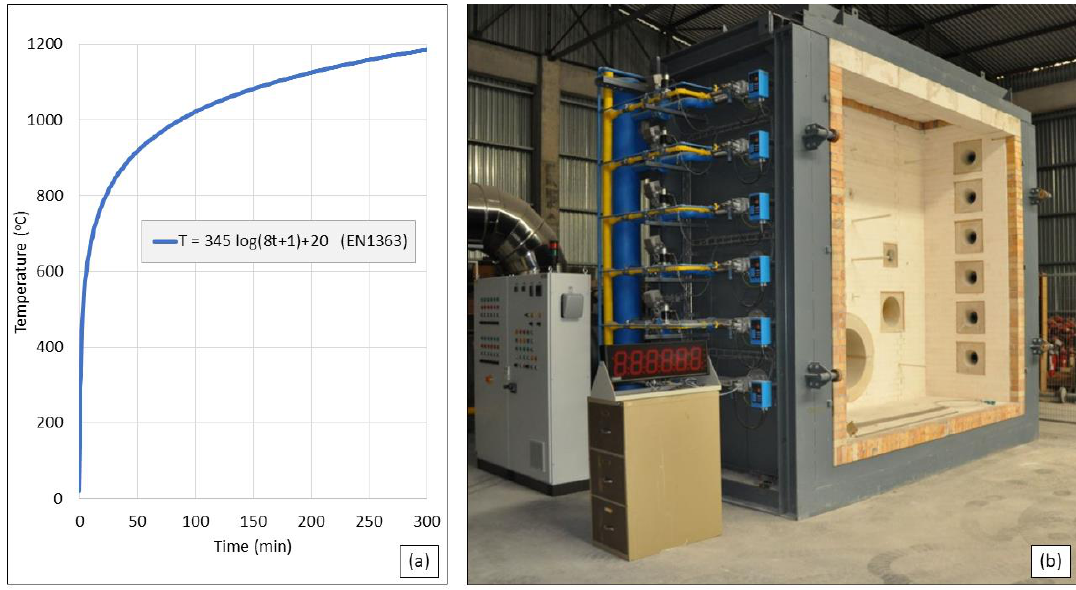
Figure 3. ( a ) Standard fire curve according to EN 1363-1; ( b ) Vertical furnace at the Fire Testing Facilities of the University of Patras (internal dimensions of 3 m × 3 m × 1.2 m).